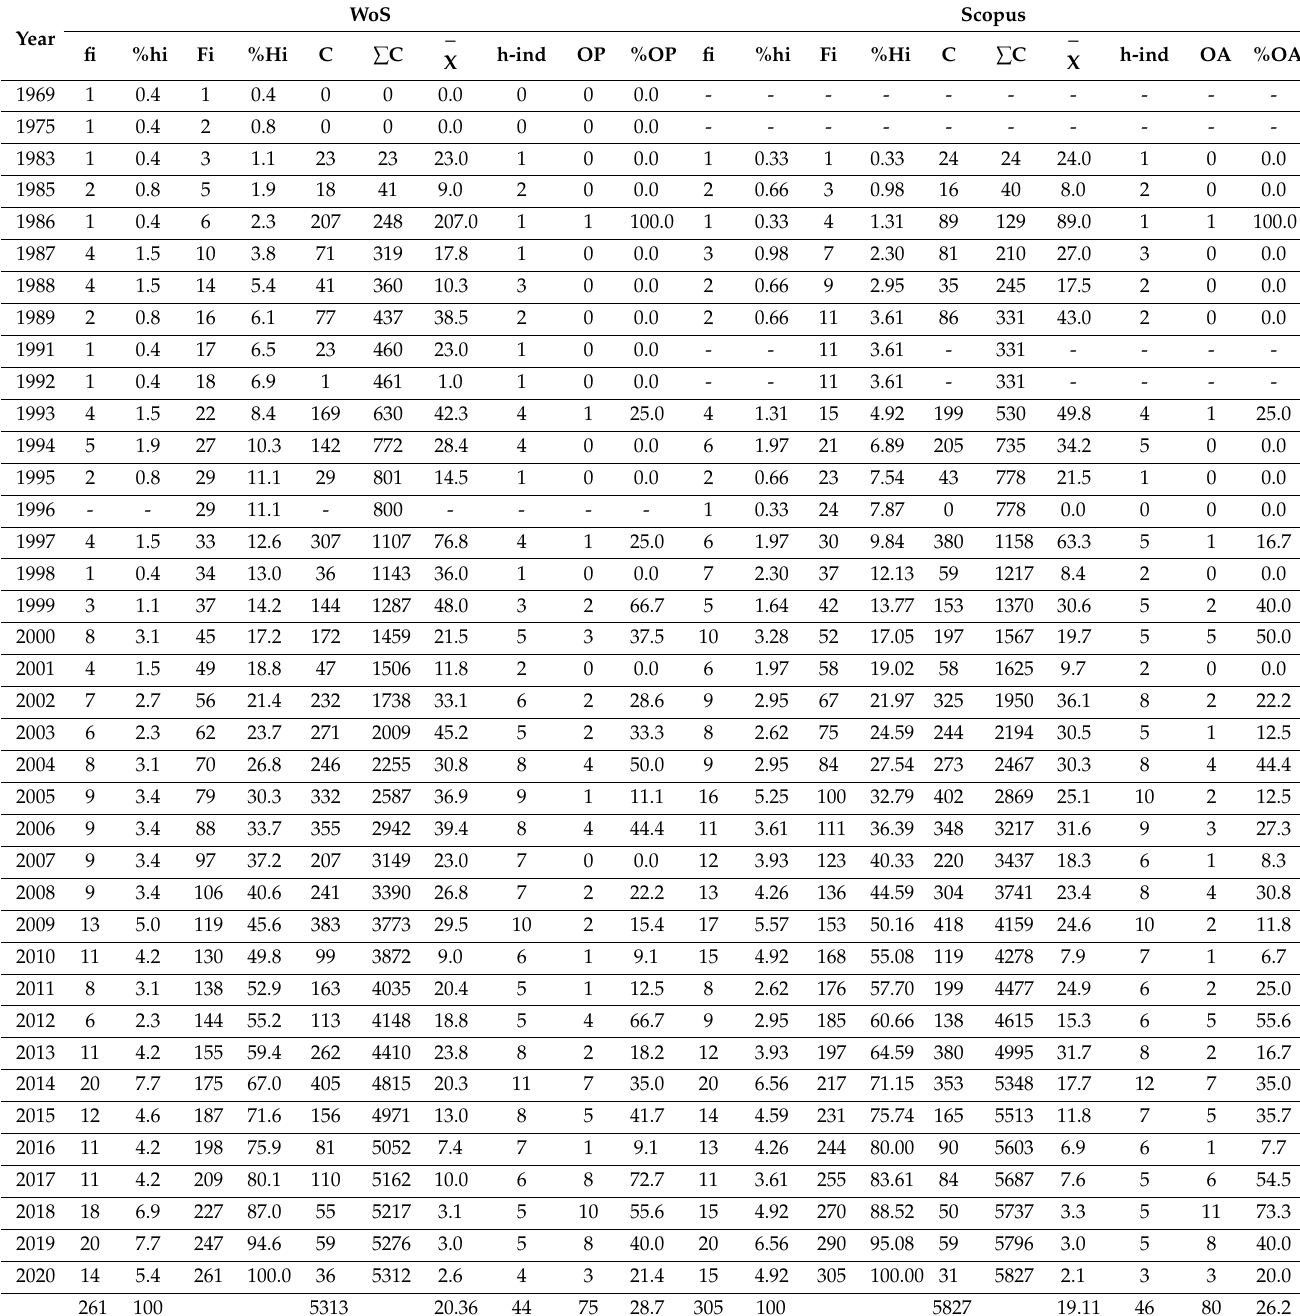
Table 6. Comparison of articles indexed in WoS and Scopus on the Water Market by